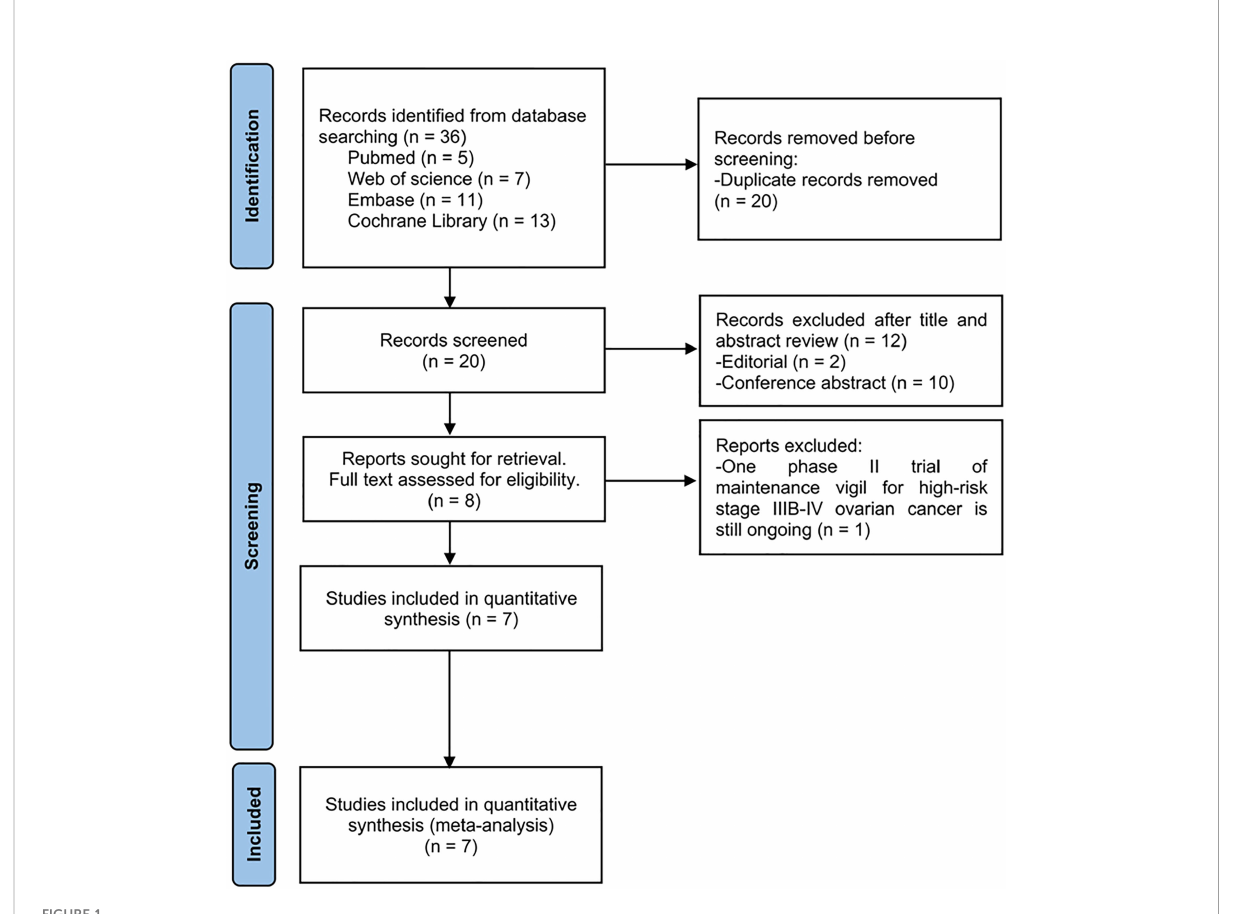
FIGURE 1 Flow chart of literature screening